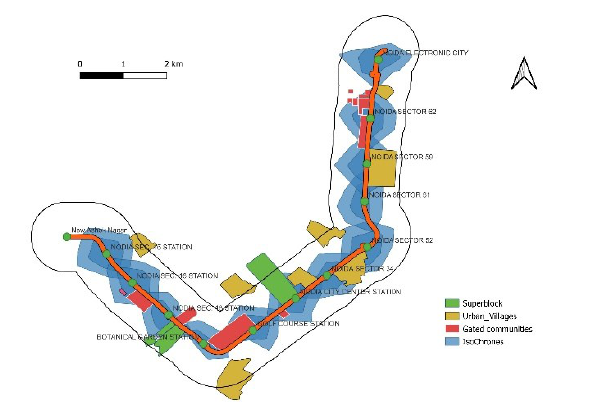
Figure 4 . Garmin Etrex 10 GPS device and Tracked GPS routes and clicked photos of the Pedestrian